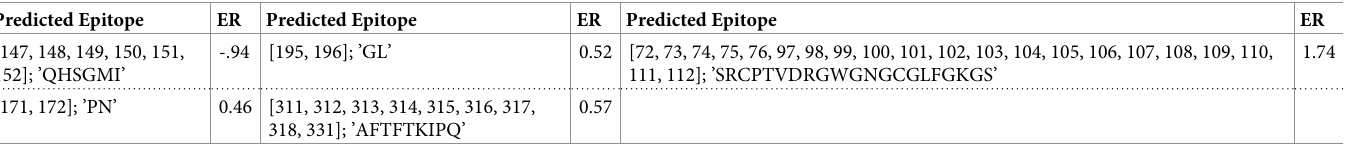
Table 5. Predicted conserved epitopes. Predicted